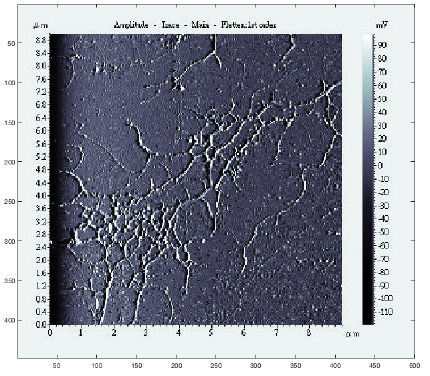
Figure 2. Example of an initialization image for LCS: a low quality raster image of DNA.